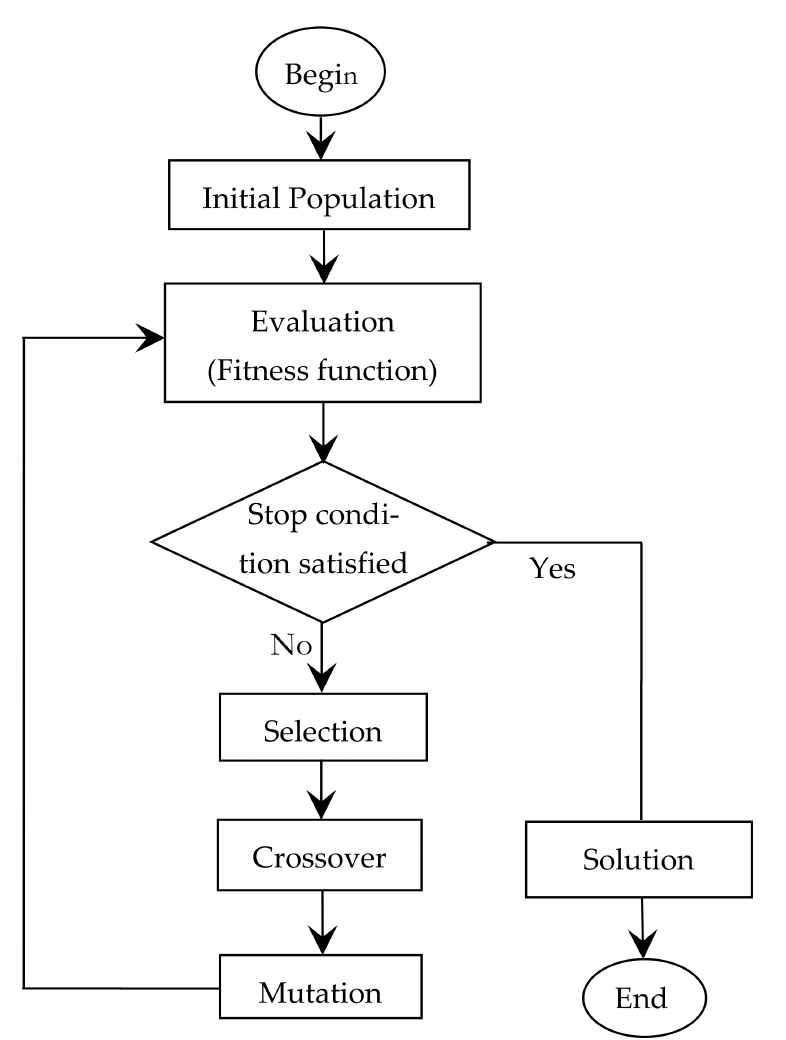
where n is the index that refers to sample points in the S 11 versus frequency function.